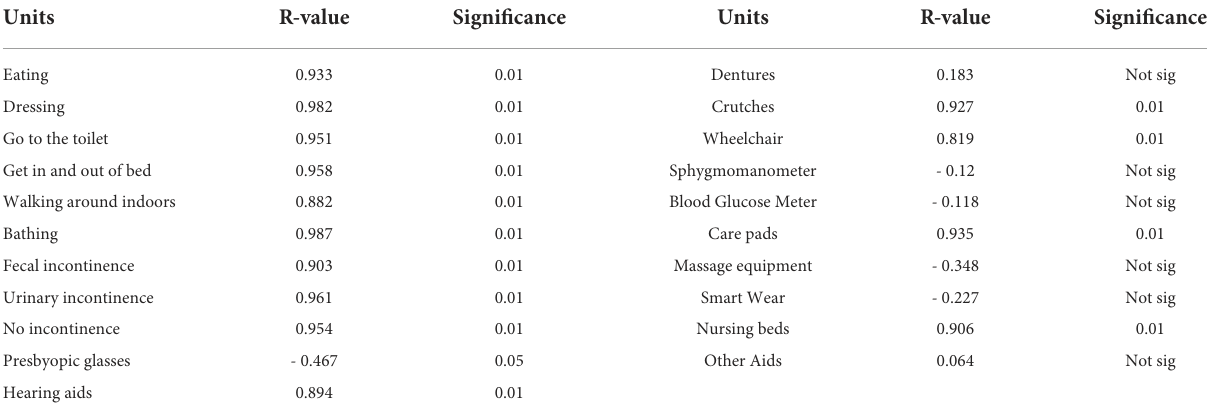
TABLE 7 Analysis related to the health care needs of the elderly.